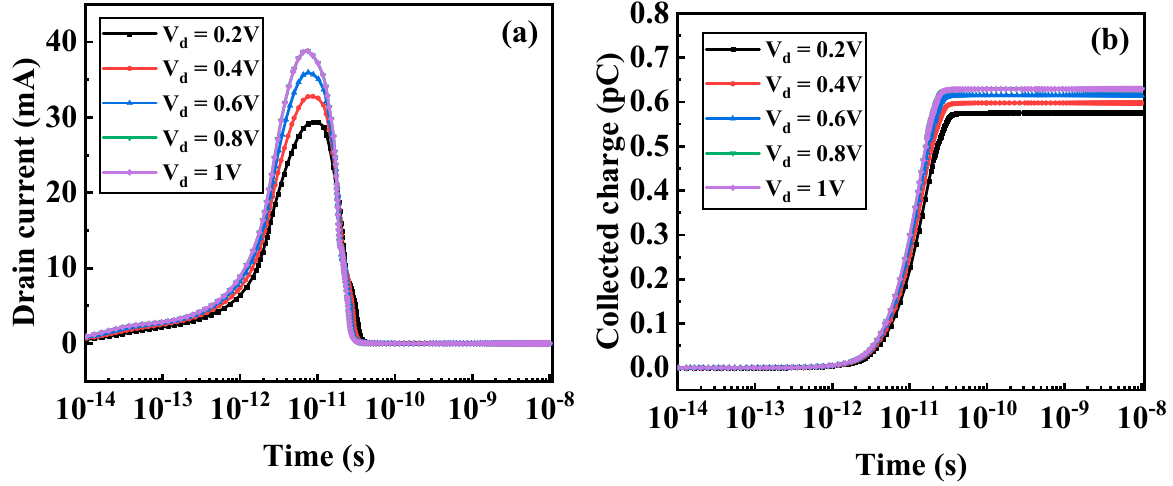
Figure 6. ( a ) Drain transient currents and ( b ) collected charge as a function of time after the ion strike with various drain biases. LET = 1000 MeV ∙ cm 2 /mg.